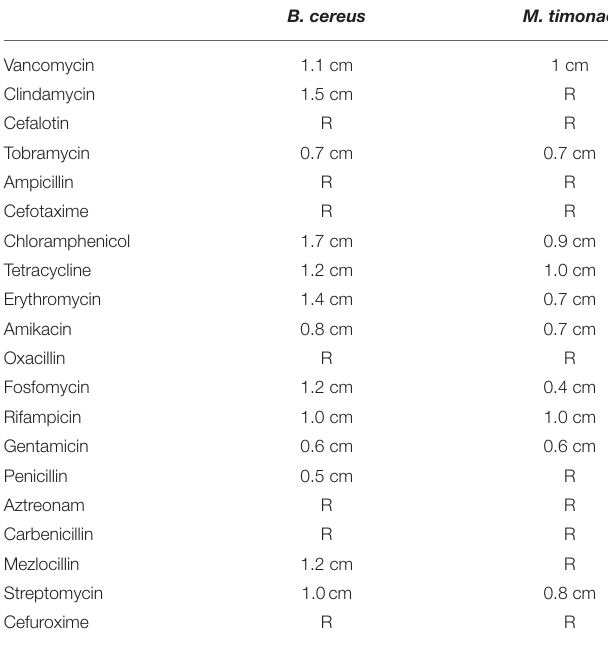
TABLE 1 | Antibiotic susceptibility of B. cereus and M. timonae